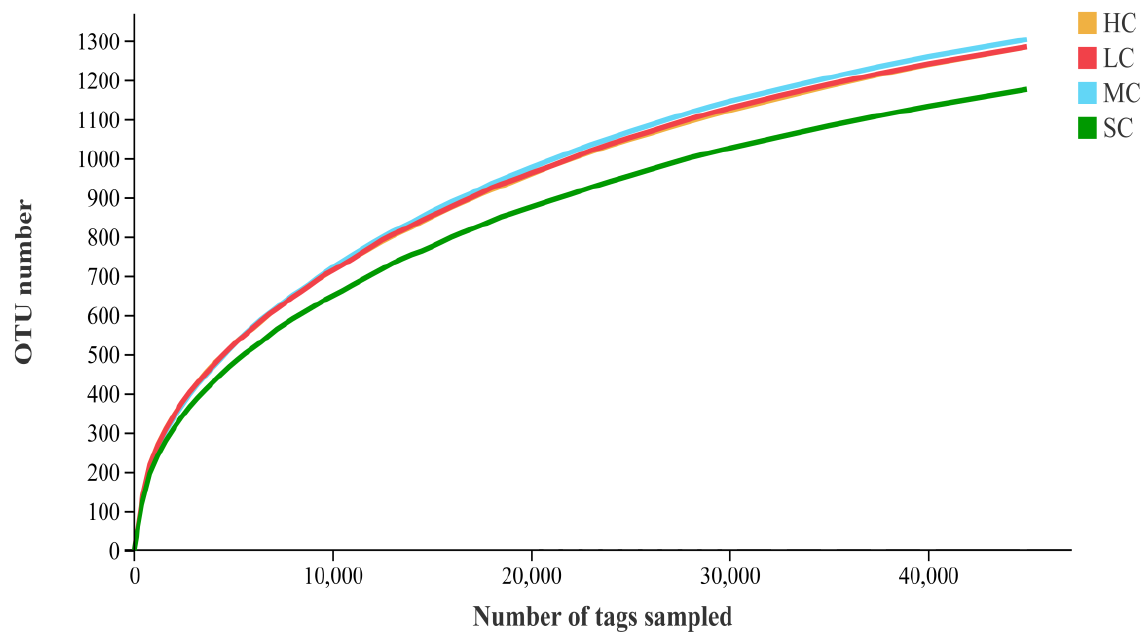
Figure 3. Rarefaction curves of the HC, LC, MC, and SC groups. OTU, operational taxonomic unit; HC, huge cage; LC, large cage; MC, medium cage; SC, small cage.